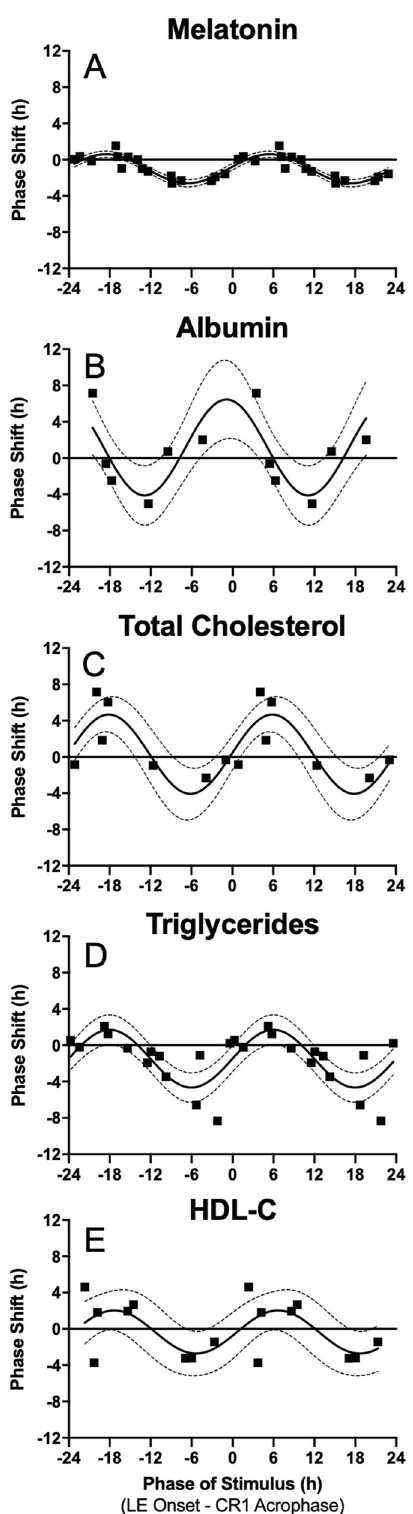
Phase response curves adjusted to relative clock time . Finally, to enable a direct comparison of PRC timings, the PRCs were re-plotted on the same scale, using the clock time of the group average CR1 acrophase as ‘ 0 ’ for the timing of the stimulus (i.e., 0 representing when light onset is coincident with the acrophase for the group during CR1, and realigned along the x-axis to the corresponding clock time) (Supplementary Fig. 6).